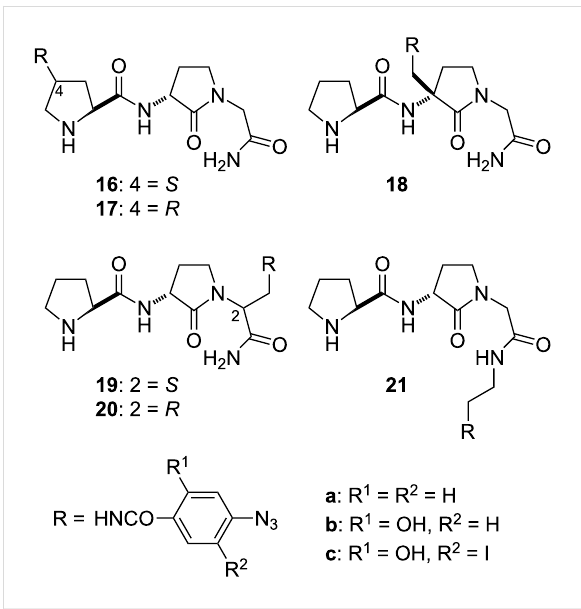
Figure 3: Lactam-based photoaffinity ligands of the PLG modulatory site. Figure 4: Bicyclic PLG